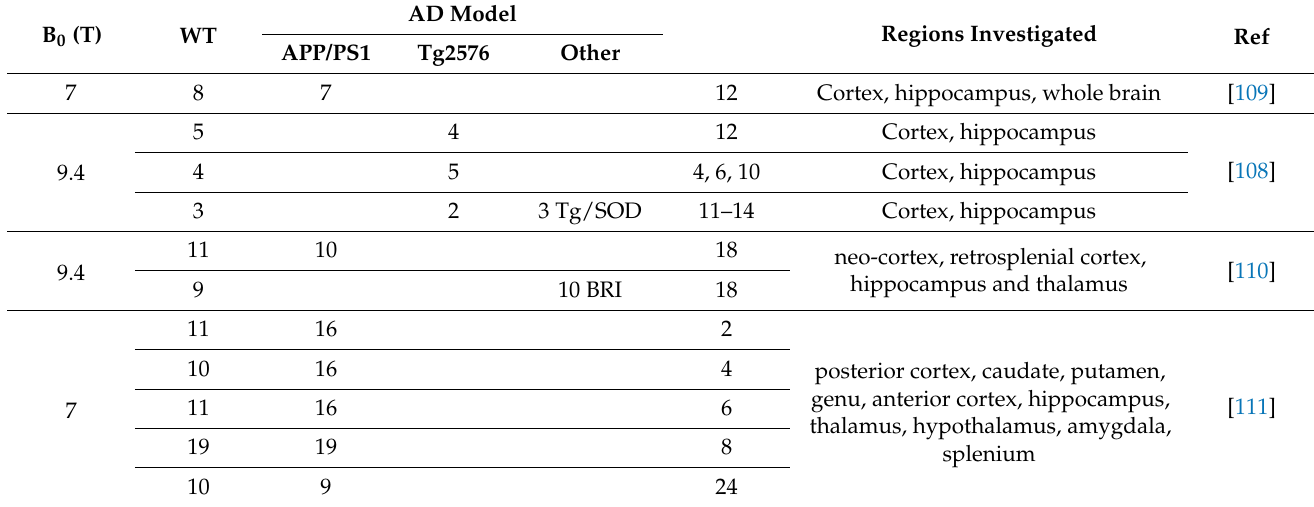
Table 3. Studies of MT in various animal models of